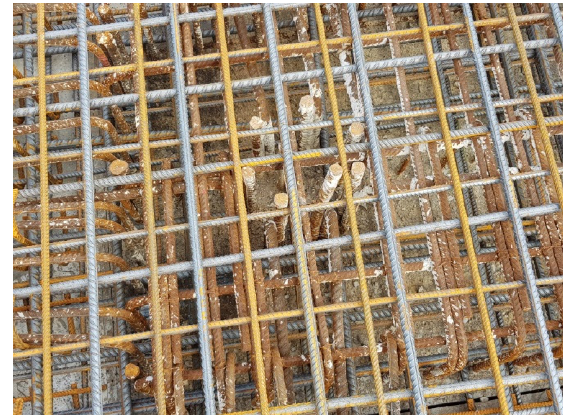
Figure 4. Picture of a finely meshed reinforcement network for watertight concrete constructions impeding easy casting of concrete.